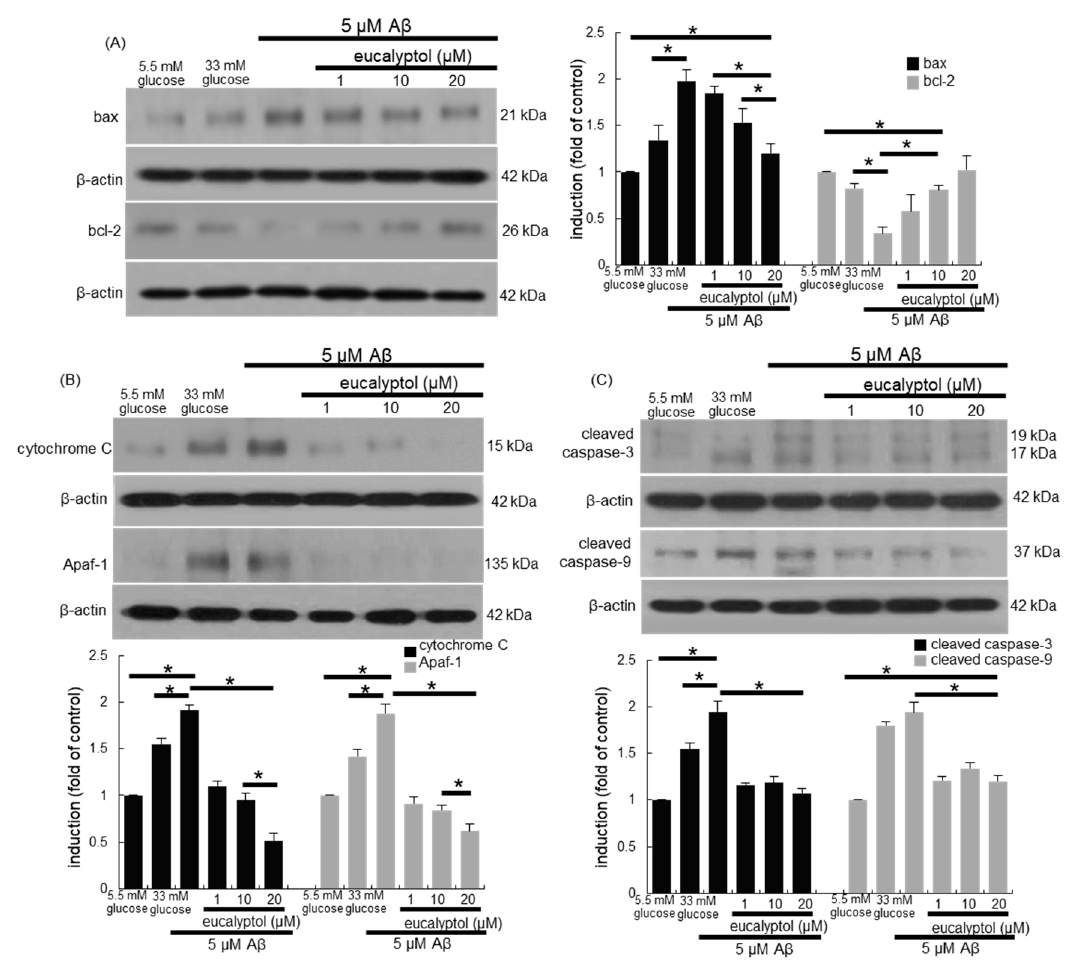
Figure 8. Blockade of A β -induced apoptosis by eucalyptol in human retinal pigment epithelial (RPE) cells. RPE cell lysates were subject to western blot analysis with a primary antibody against bax, bcl-2, cytochrome C, Apaf-1, cleaved caspase-3, cleaved caspase-9 and β -actin for an internal control ( A – C ). Bar graphs (mean ± SEM, n = 3) in the panels represent densitometric results of blot bands. * Values in respective bar graphs indicate a significant difference at p < 0.05.